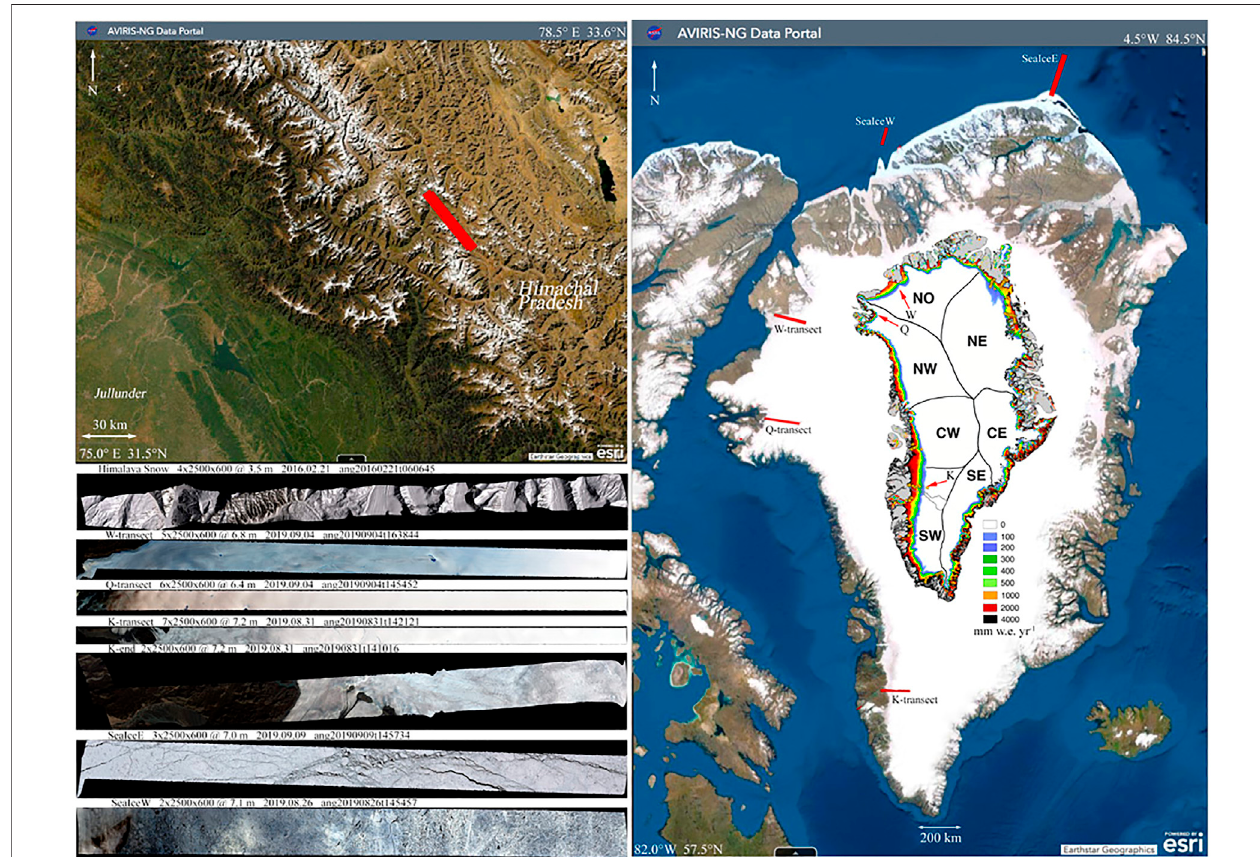
FIGURE 1 | Index maps with natural color composites of AVIRIS-NG acquisitions used to construct the cryospheric spectral cube and feature space. All three Greenland transect lines span transitions from ablation zones at western ends to accumulation zones at eastern ends. Inset modeled runoff map from (Noël et al., 2019) shows each transect spanning distinct snow-ice gradients. The SeaIce E and W lines both contain pack ice spanning a range of fragmentation, open water and snow cover conditions. The Himalayan snow line contains uniform snow cover on a variety of mountain glaciers and rock/soil substrate ridges having a wide range of slopes and aspects giving rise to a wide range of view and illumination geometries.Only cloud-free fully illuminated sections oflinesare included in the composite mixing space.